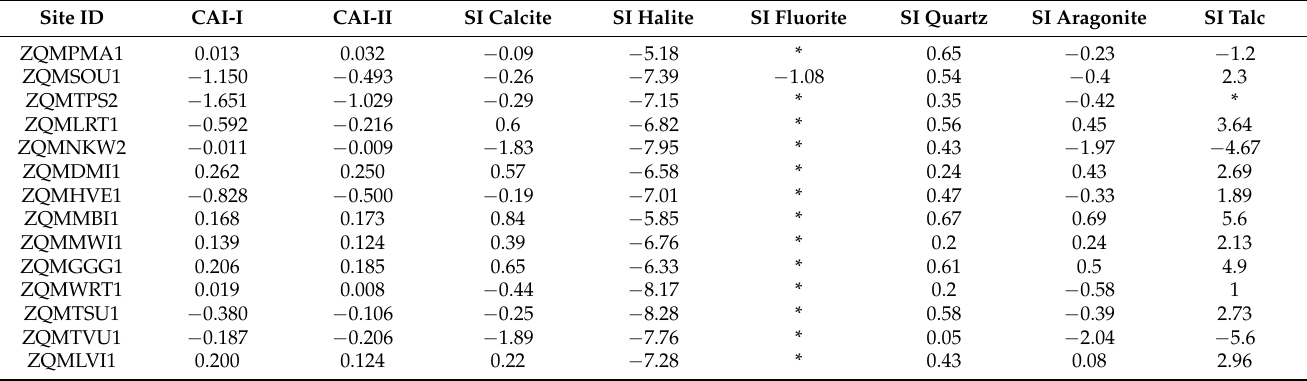
Table 3. Chloro-alkaline indices (CAIs) and saturation indexes (SIs) for all